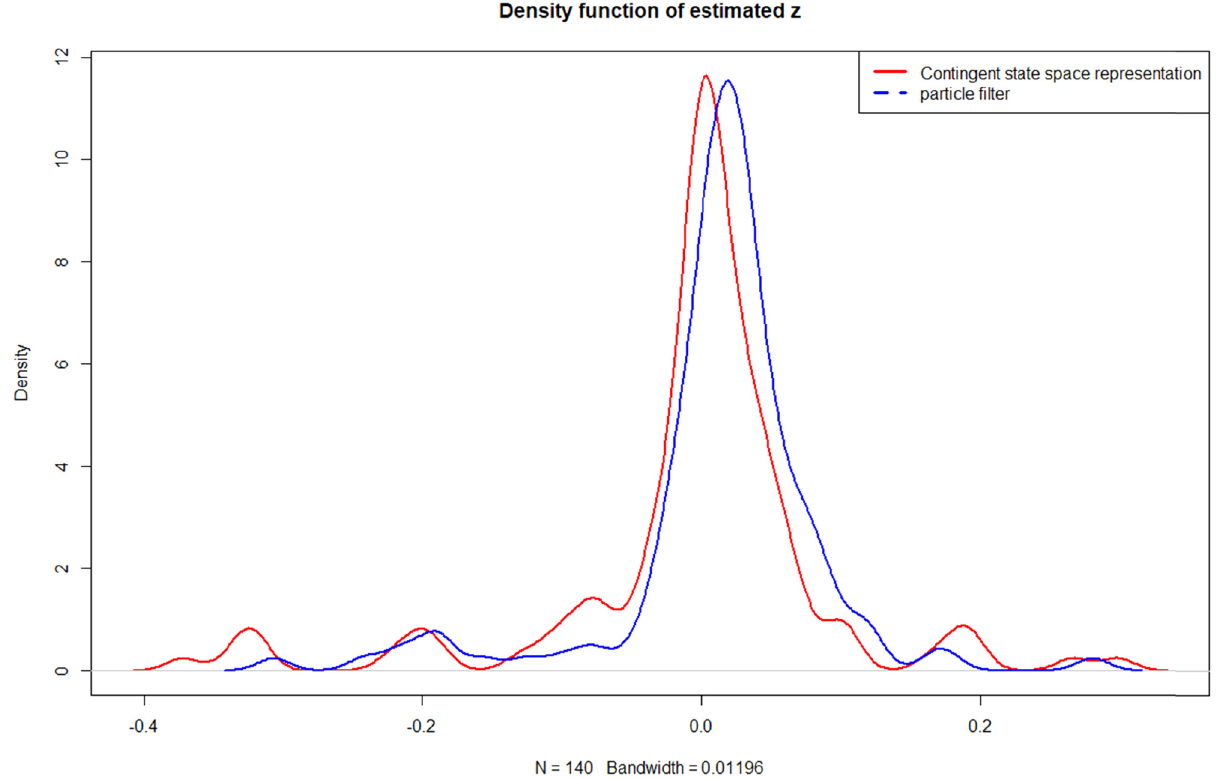
Figure 4: Density functions of z t variable using both estimating approaches.